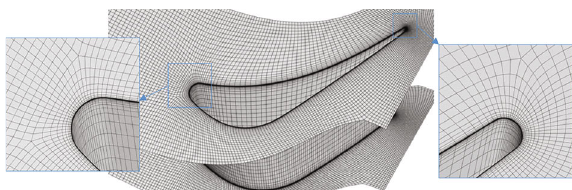
Figure 5: Q3D analysis process.